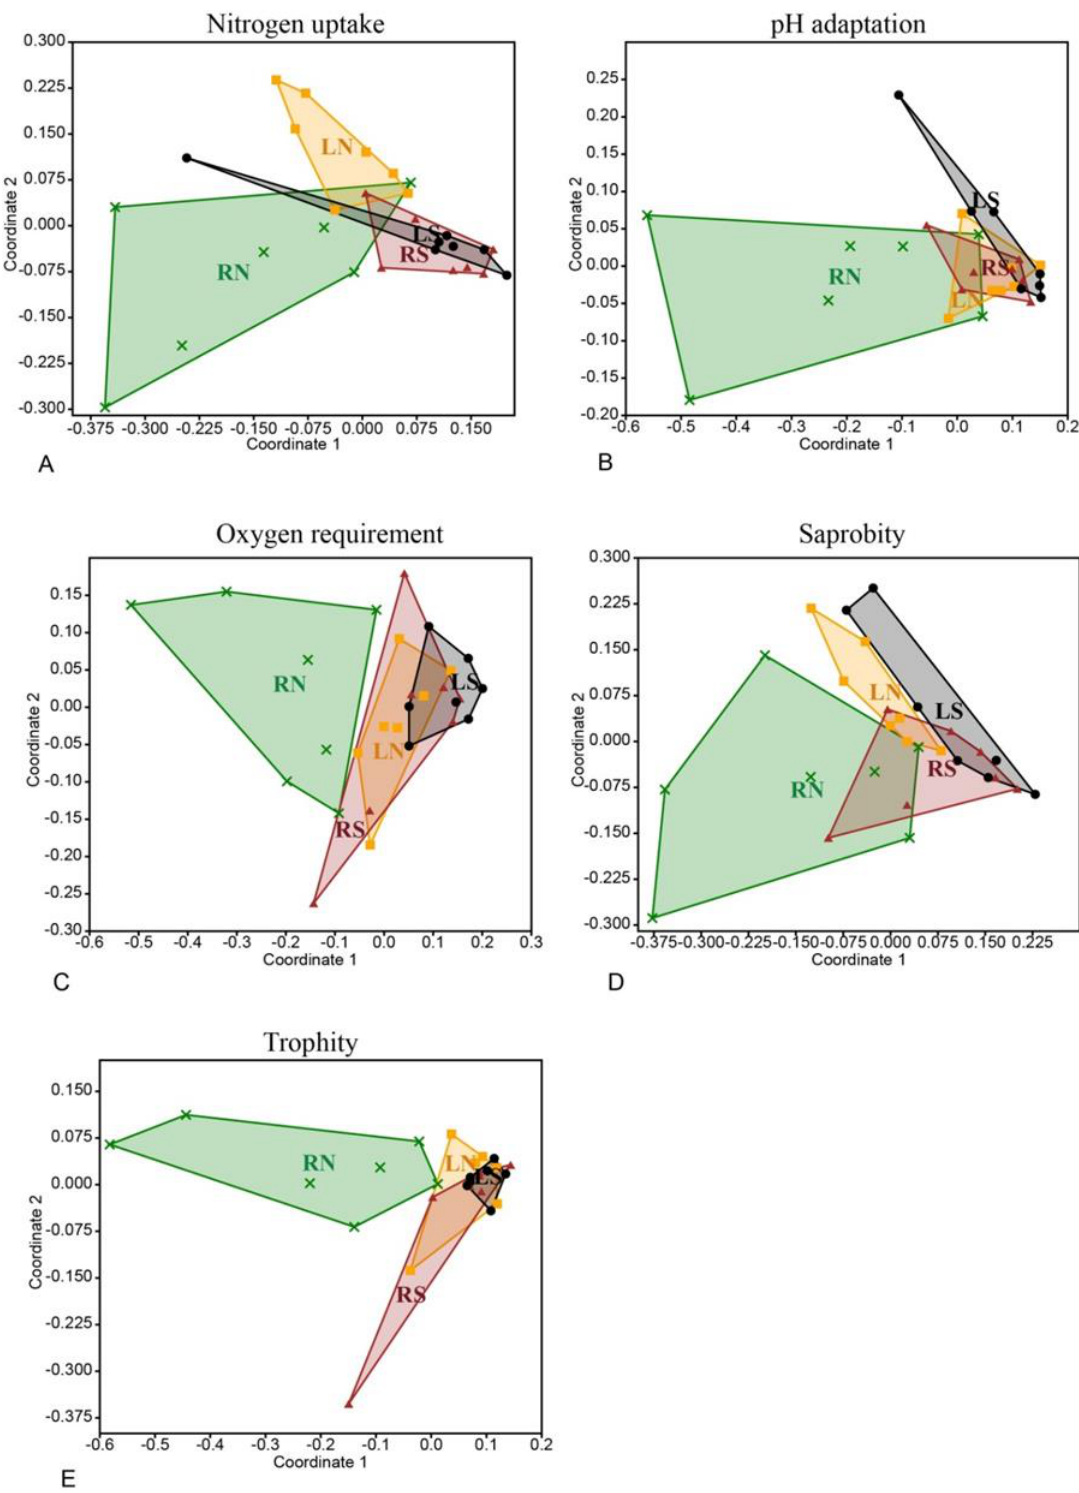
Figure 6. Non-metric multidimensional scaling (NMDS) with Bray-Curtis dissimilarity index illustrating the separation of samples based on the relative abundances of the categories of traits defined by van Dam et al. [22] in samples from the four sampling points. ( A ) Nitrogen adaptation strategy, ( B ) pH adaptation strategy, ( C ) oxygen requirement, ( D ) saprobity, ( E ) trophity. Markings: green cross—samples from upstream, right bank (RN), orange filled square—samples from upstream, left bank (LN), brown filled triangle—samples from downstream, right bank (RS), black dot—samples from downstream, left bank (LS).